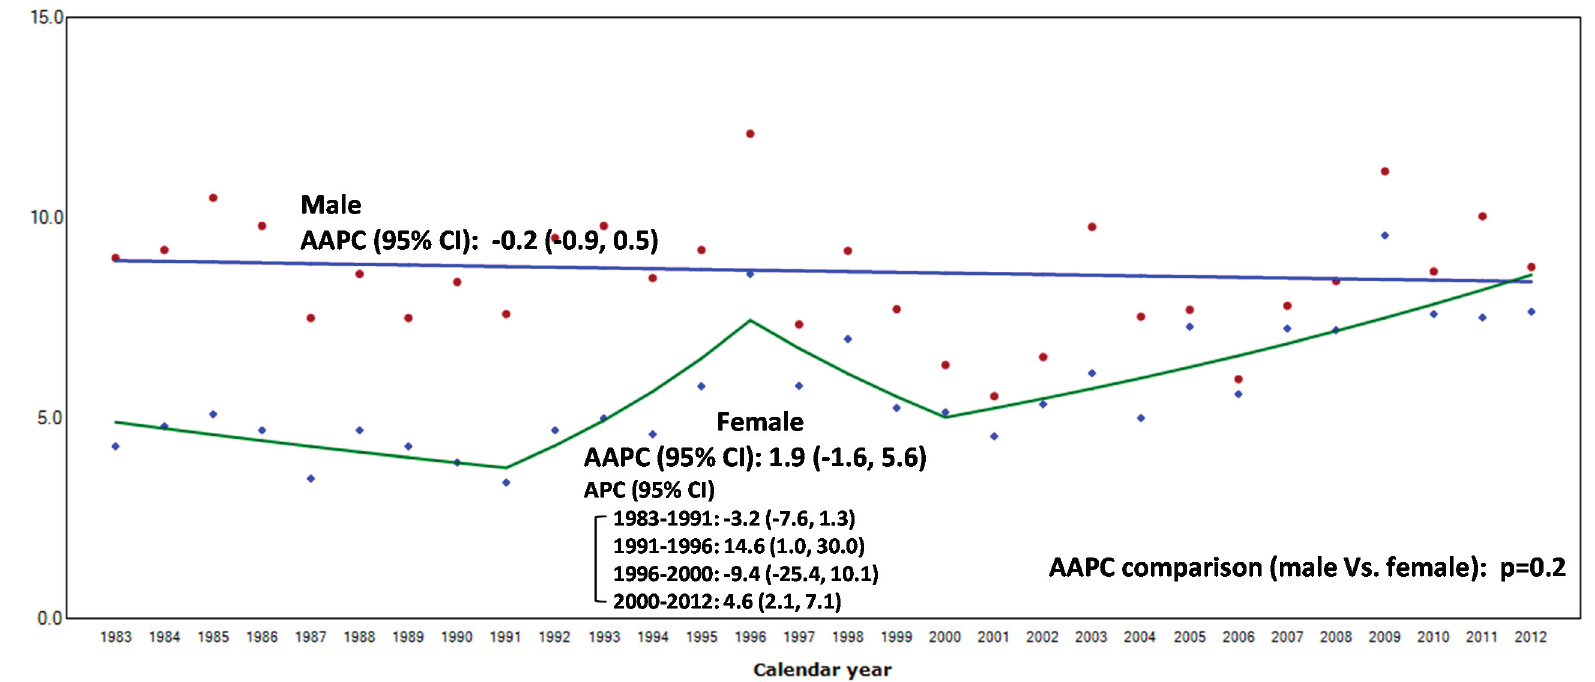
Figure 1. Suicide rate, annual percent change (APC), and annual average percent change (AAPC) according to gender among adolescents, 15 – 19 years of age in Korea, 1983–2012 (data from KOSIS [2]); Model selection and p -value of AAPC comparison test estimated using Monte Carlo Permutation method